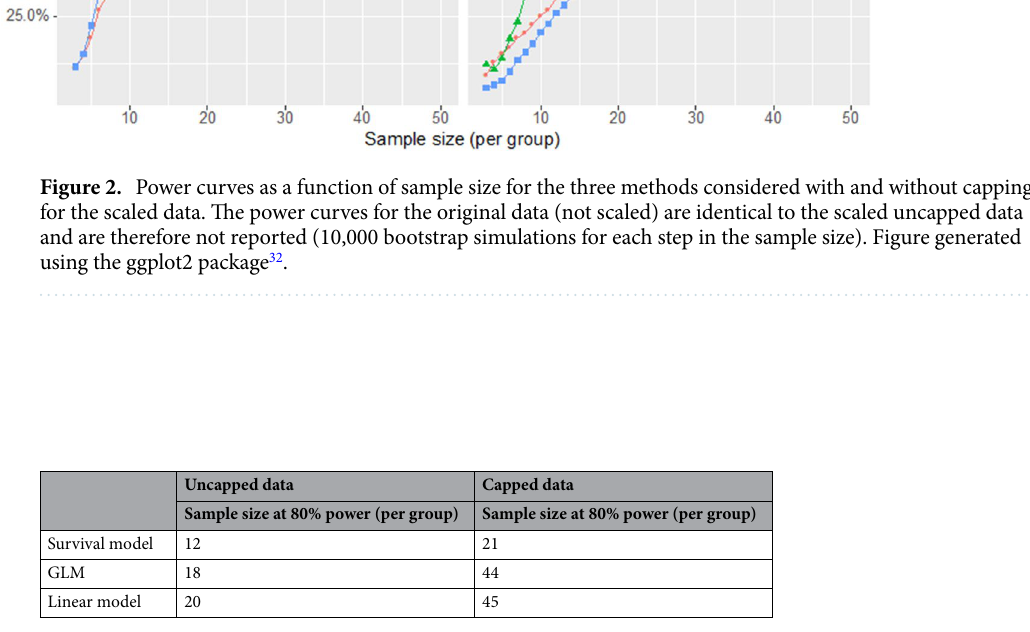
Table 3. Sample size (to whole number) of each group required to reach 80% power at α = 0.05 with the three methods